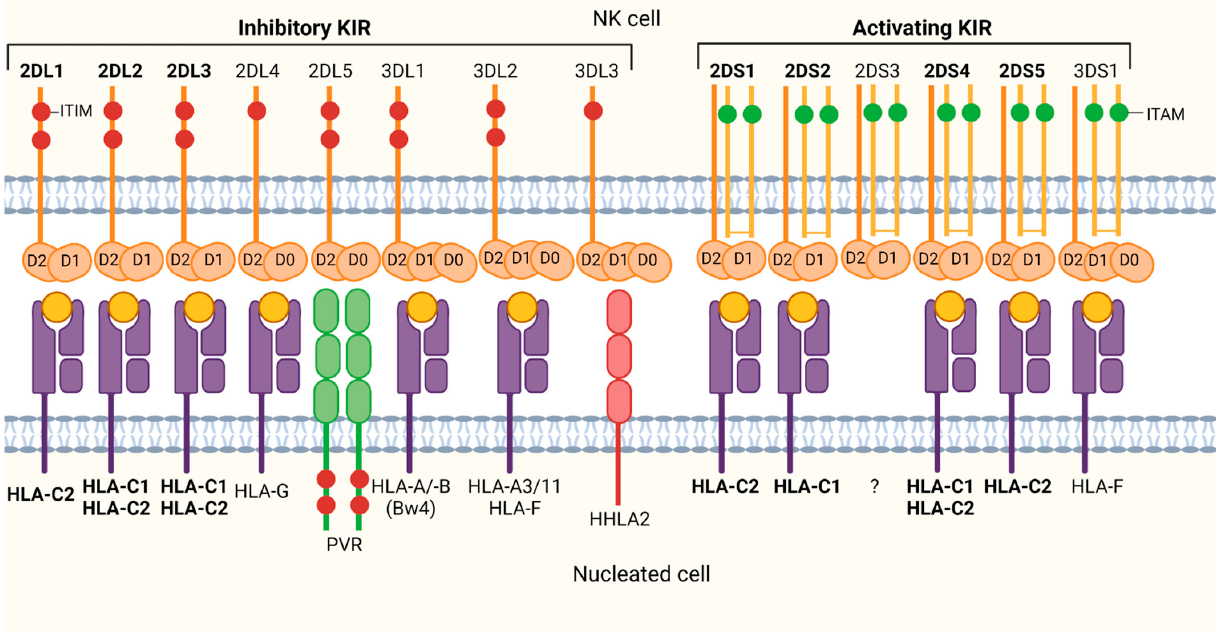
Figure 3. KIR family and respective HLA class I ligands. Illustration of the structure and distribution of inhibitory and activating KIRs and their respective ligands. Killer-cell immunoglobulin-like receptors (KIR) (orange), expressed predominantly on NK cells, interact mainly with HLA class I molecules (purple) and its presented peptides (yellow). Each KIR exhibits a specificity for only a selection of HLA class I molecules, including HLA-C allotypes (bold). For example, inhibitory KIR2DL1 and activating KIR2DS1 exclusively interact with HLA-C2, while the inhibitory receptors KIR2DL2/L3 are cross-reactive for the HLA-C1 and -C2 allotypes. Inhibitory KIRs (and the poliovirus receptor (PVR)) carry immunoreceptor tyrosine-based inhibitory motifs (ITIM, red circles), signaling NK cell inhibition upon receptor- ligand engagement, whereas activating KIRs associate with adapter molecules that contain immunoreceptor tyrosine-based activation motifs (ITAMs, green circles) conferring an activating signal. Created with